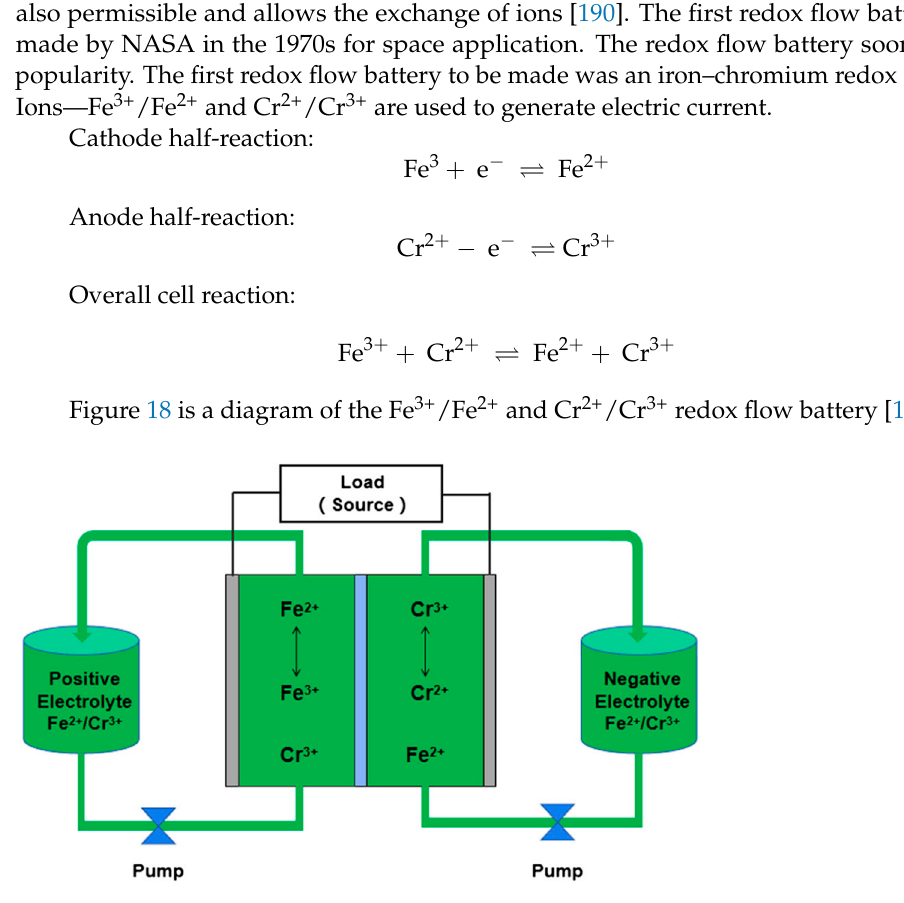
Figure 18. Fe 3+ /Fe 2+ and Cr 2+ /Cr 3+ redox flow battery.